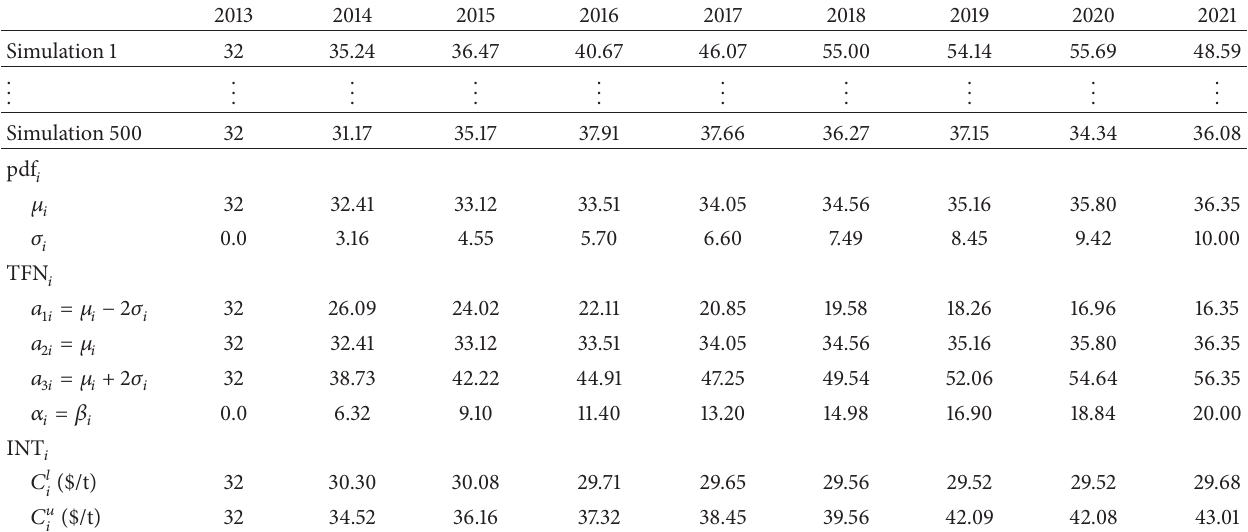
Table 5: Simulation of the unit operating costs.